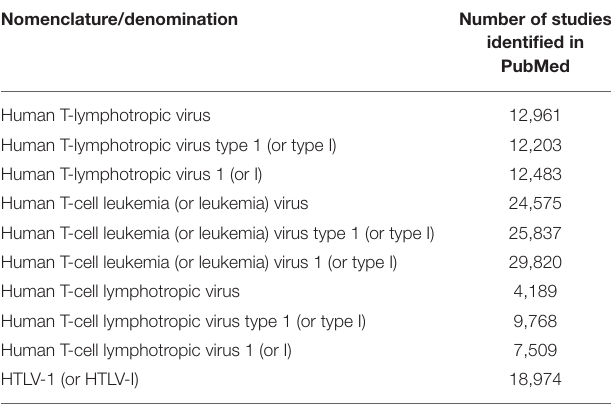
TABLE 1 | The impact of search systems of HTLV nomenclature/denomination on scientific literature based on